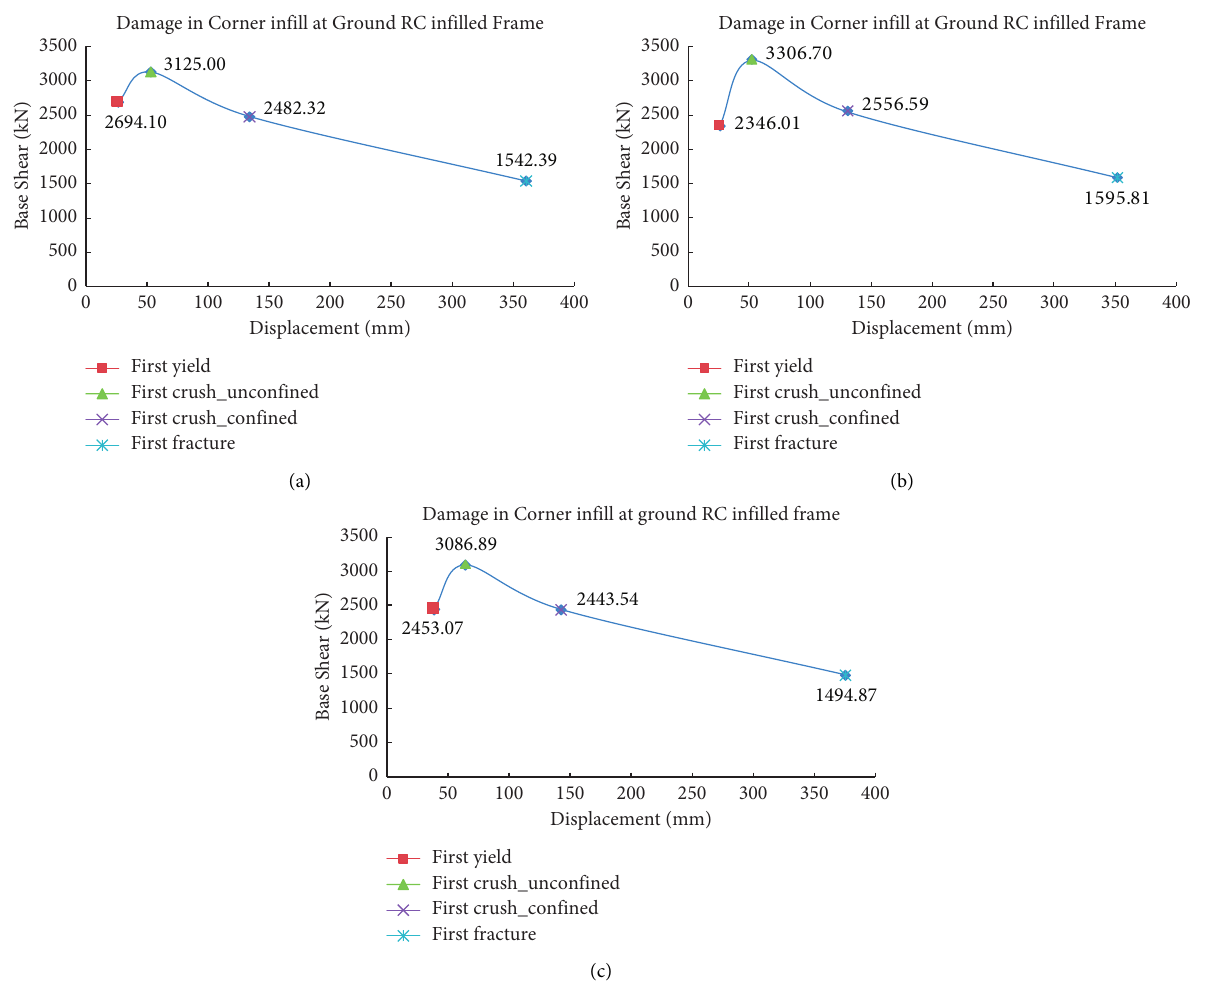
Figure 13: Damage pattern of the corner infill at ground RC infilled frame for different values of the compressive strength of infill: (a) 5MPa; (b) 4 MPa; (c)